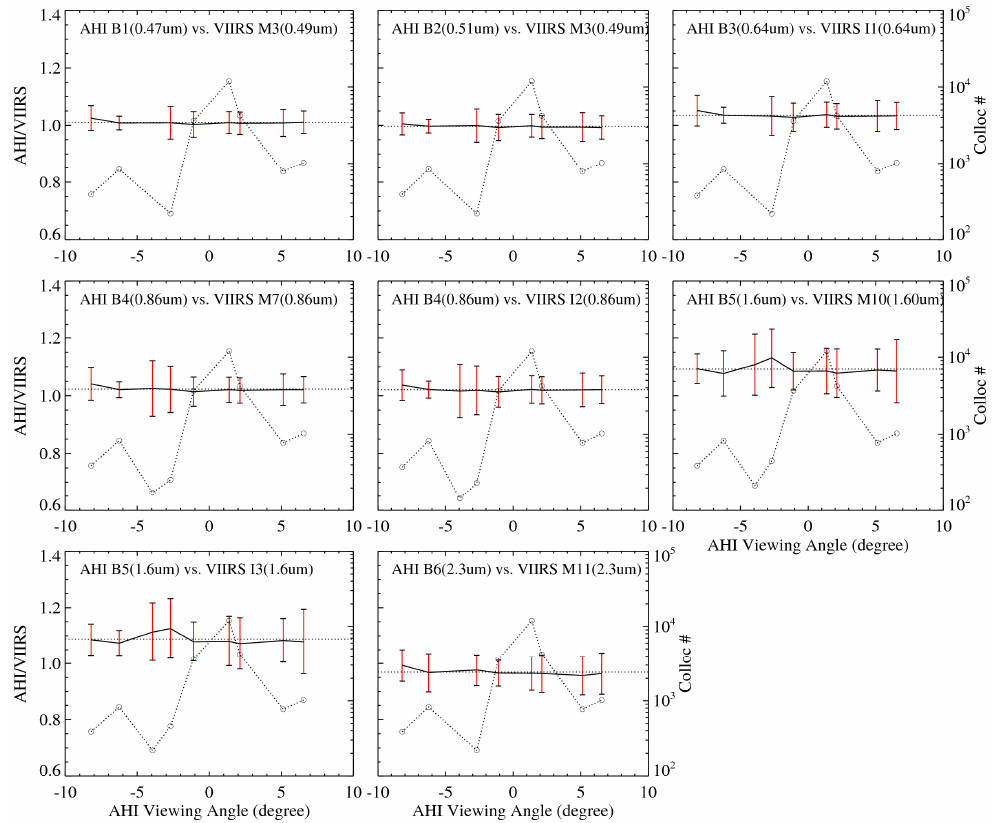
Figure 6. The E–W viewing angle dependent reflectance ratio between AHI and VIIRS for the data collected from 20 June to 20 August 2015. The red segments represent the standard deviation of the reflectance ratio at each valid bin. The open circles connected with dashed lines are the number of selected scenes and are referred with the second y-axis which ranges from 10 2 to 10 5 . The x-axis is AHI viewing angle in degree.